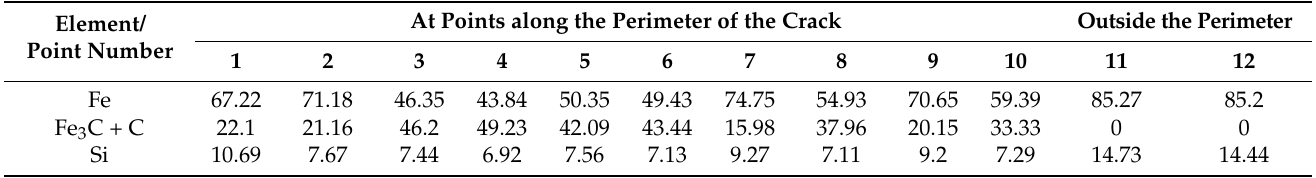
Figure 8. Elemental SEM-EDS analysis of the chemical composition along the edges of the crack: a is a crack fragment (sample no.), b is location of chemical composition analysis points. Table 6. Chemical composition of sample no. in the crack area, at.%